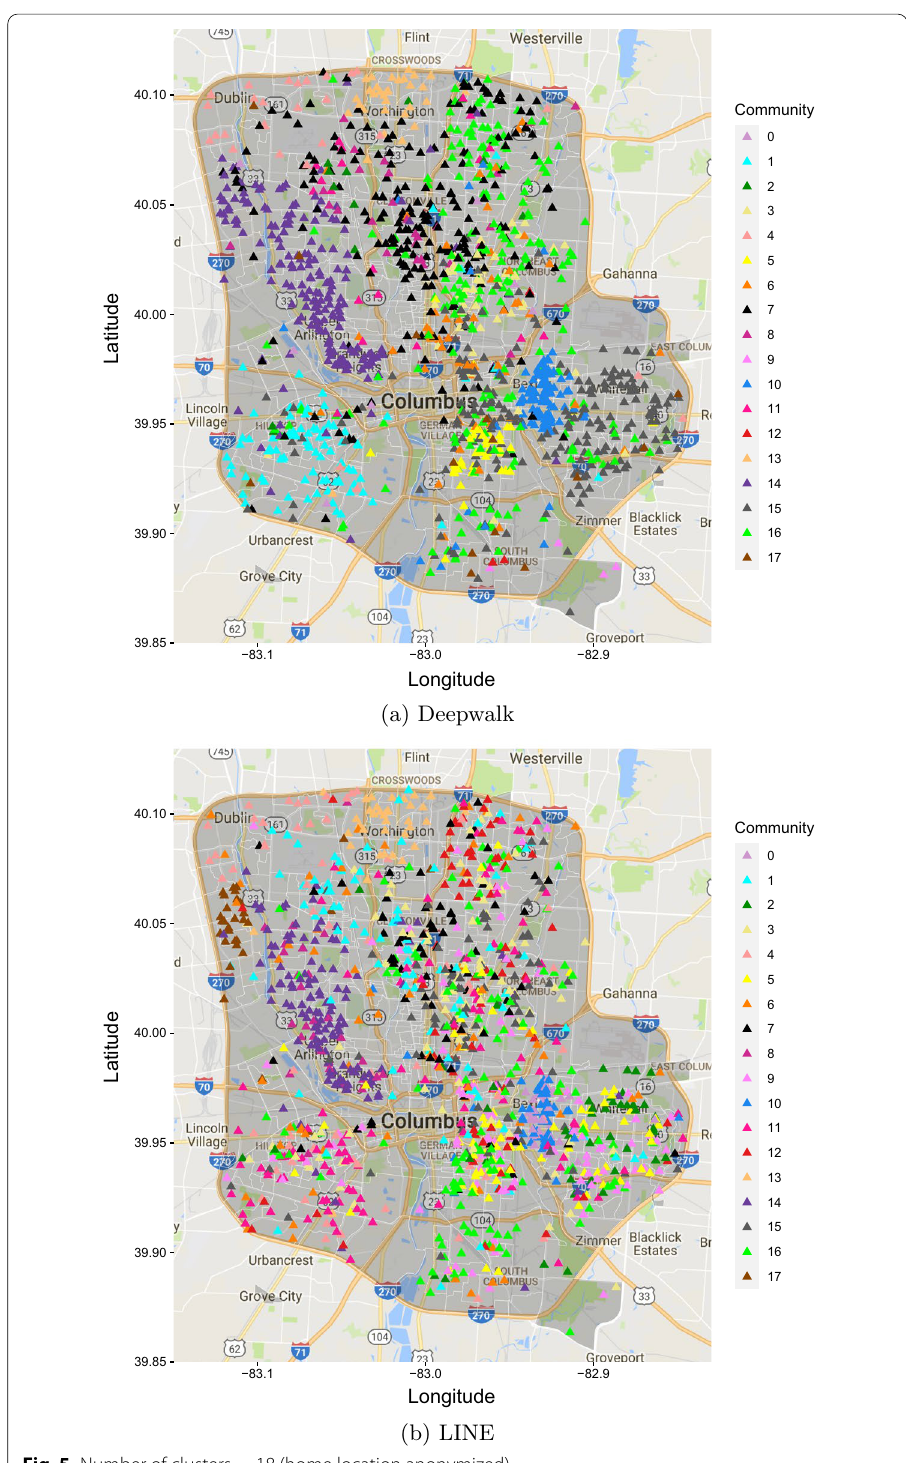
Fig. 5 Number of clusters